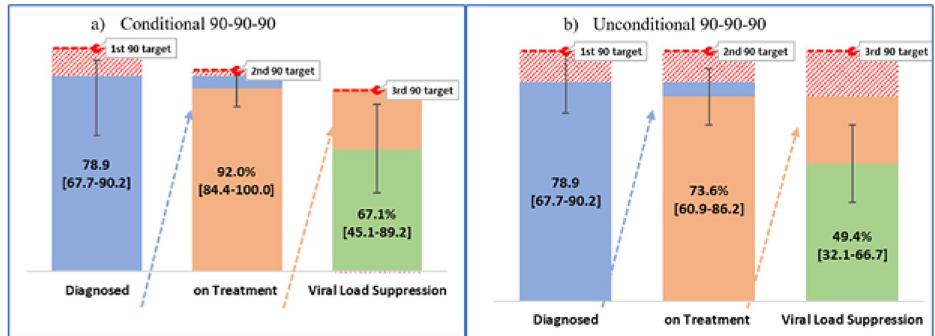
Fig 1. 90-90-90 HIV cascade among children living with HIV, KENPHIA 2018, a) conditional; b) unconditional.